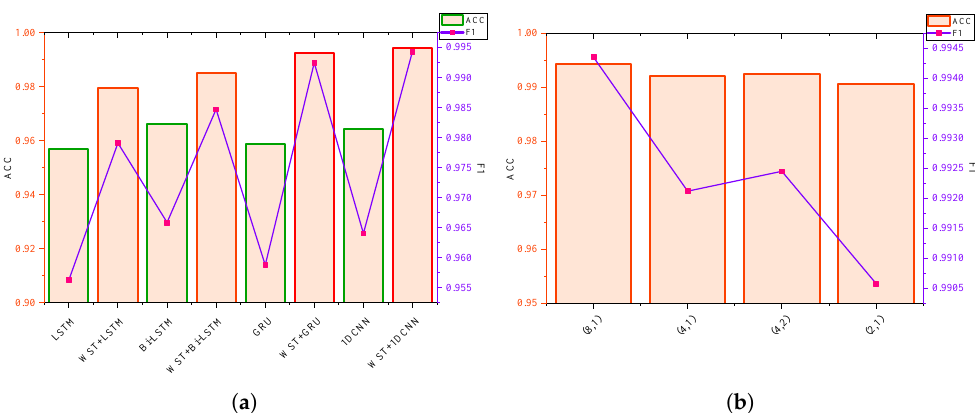
Figure 9. Comparison of ablation study results. ( a ) Results comparison using wavelet scattering transform versus without wavelet scattering transform methods. ( b ) Comparison of the results of the combination of the number of wavelets per octave of the filter bank.